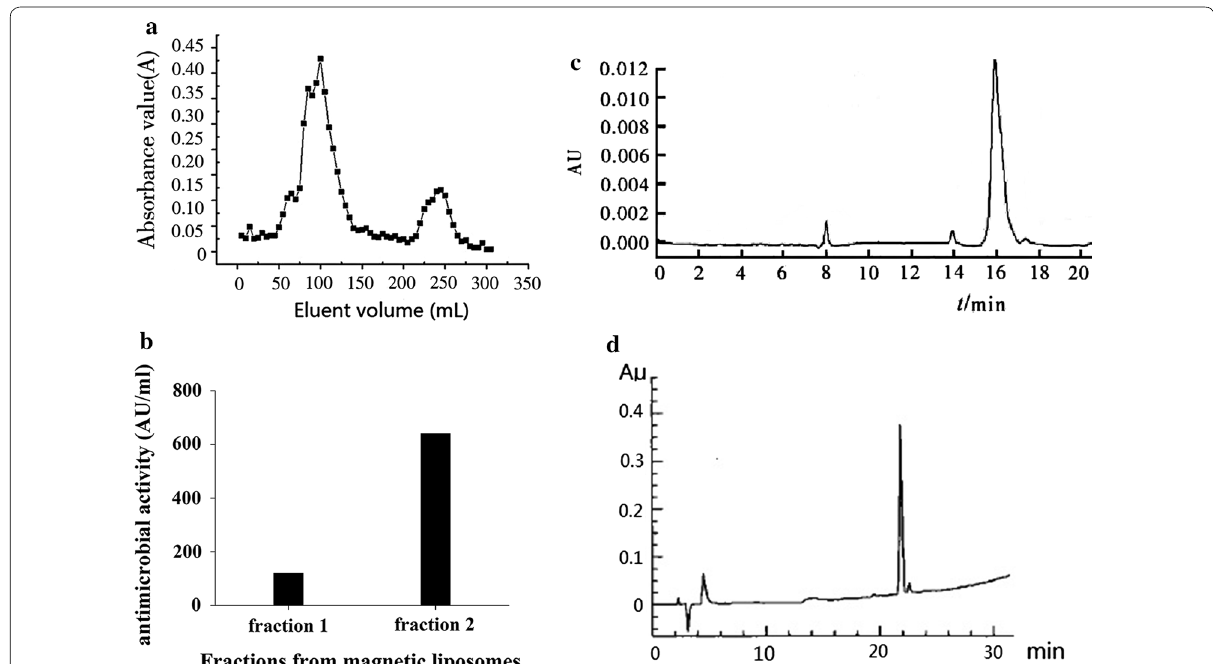
Fig. 2 Purification of antimicrobial peptides from hydrolysates of waste yak milk. a Fractions from magnetic liposomes; b antimicrobial activity of fractions; c RP-HPLC spectrum of the purified antimicrobial peptide from elution #1; d RP-HPLC spectrum of the purified antimicrobial peptide from elution